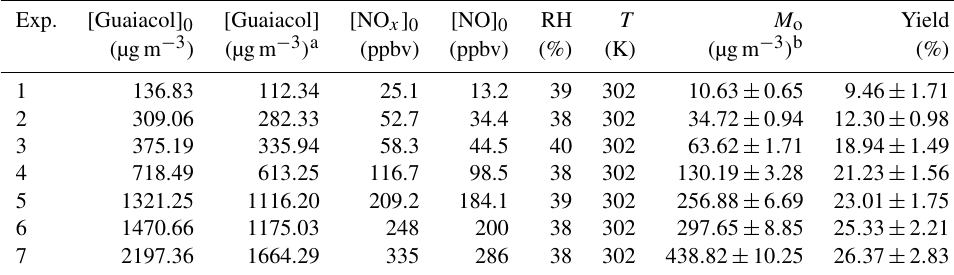
Table 1. Experimental conditions and results for guaiacol photooxidation in the presence NO x . Exp.